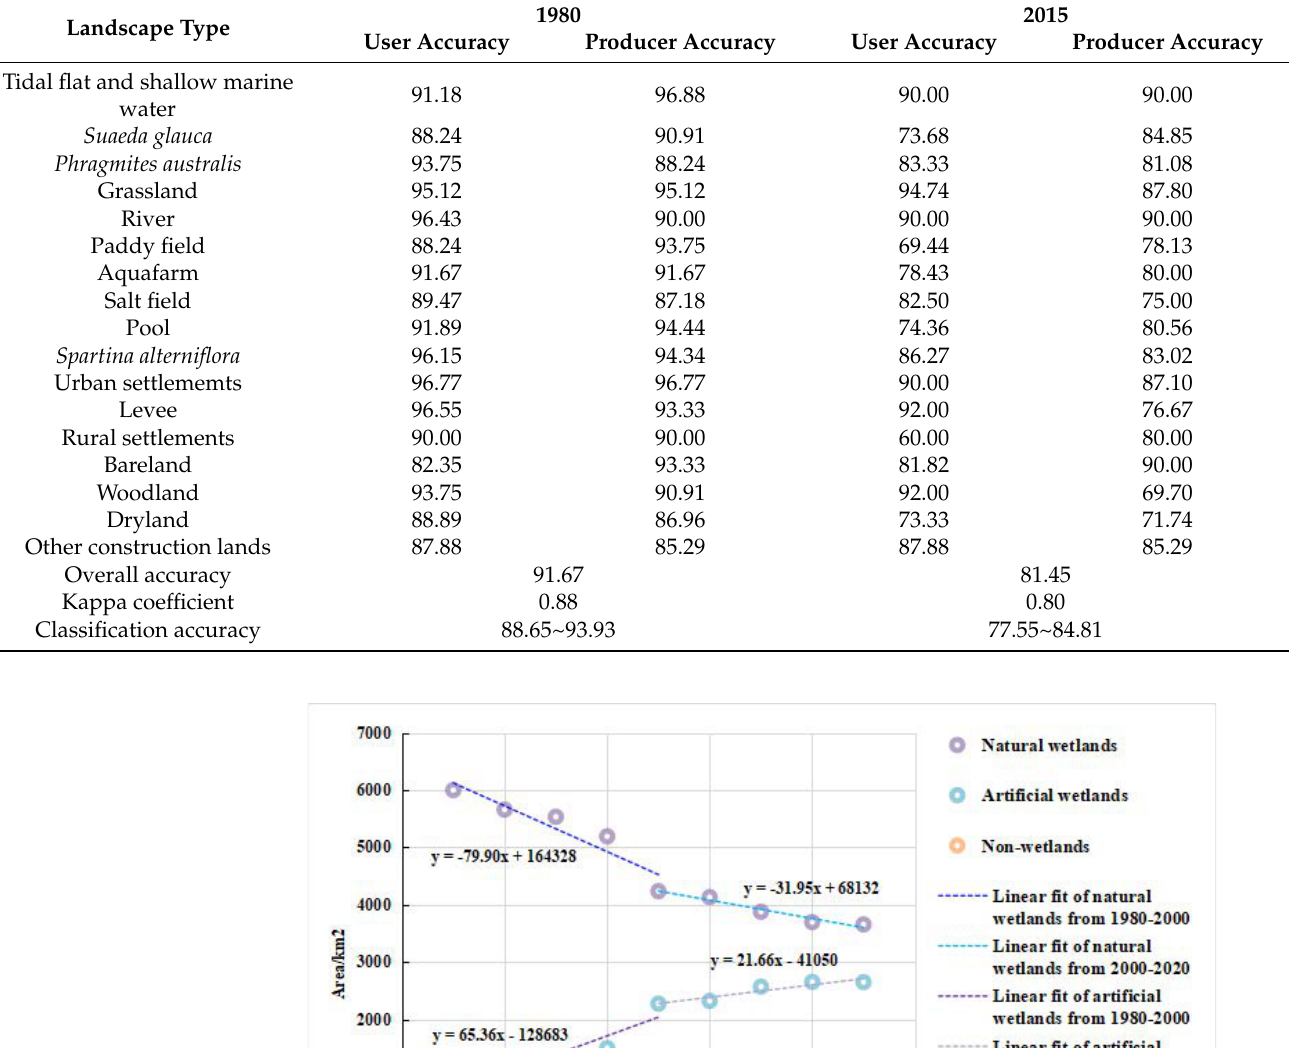
Table 3. Accuracy of landscape classification results (%).